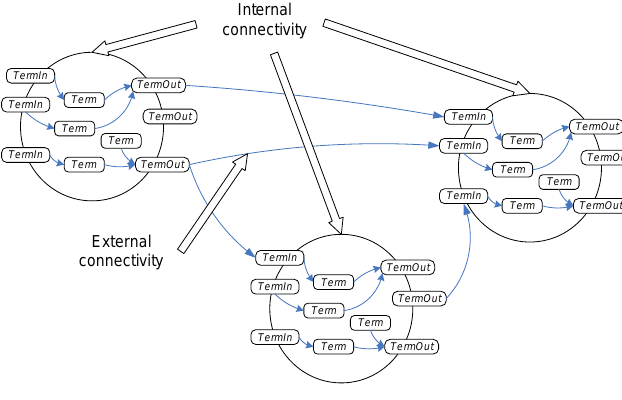
Fig.4. Internal and external connectivity of